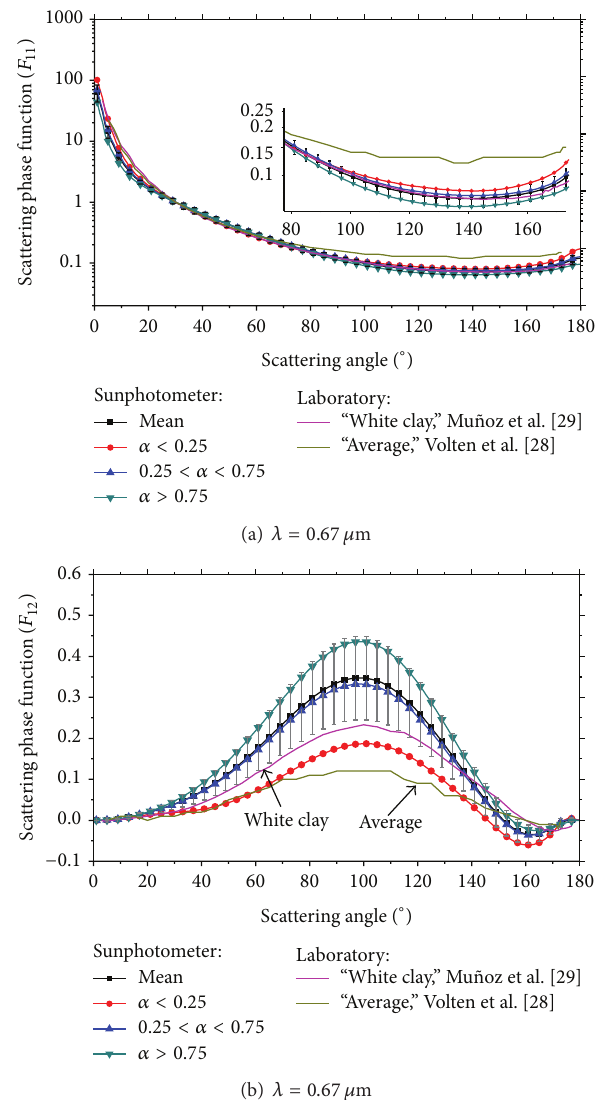
Figure 11: The scattering matrix of mineral dust aerosols in Minqin: (a) the scattering phase function ( 𝐹 11 ) normalized to 1 at 30 degrees and (b) the degree of linear polarization for unpolarized incident light ( −𝐹 12 /𝐹 11 ).